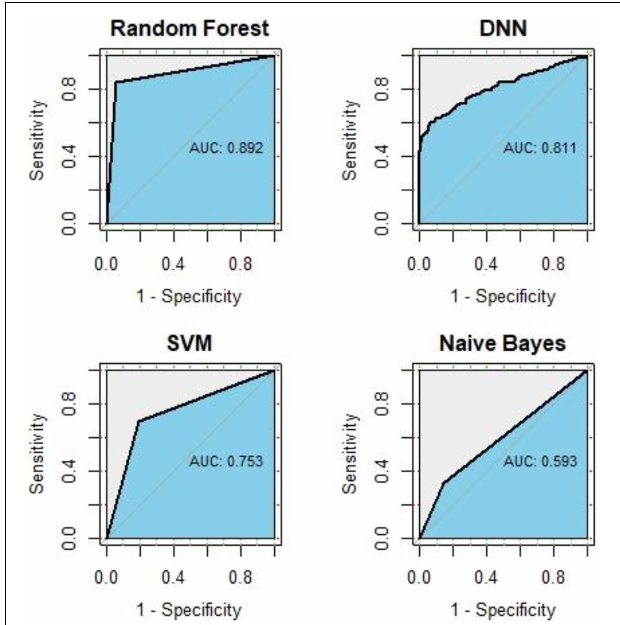
FIGURE 2 | Comparison of prediction performance.